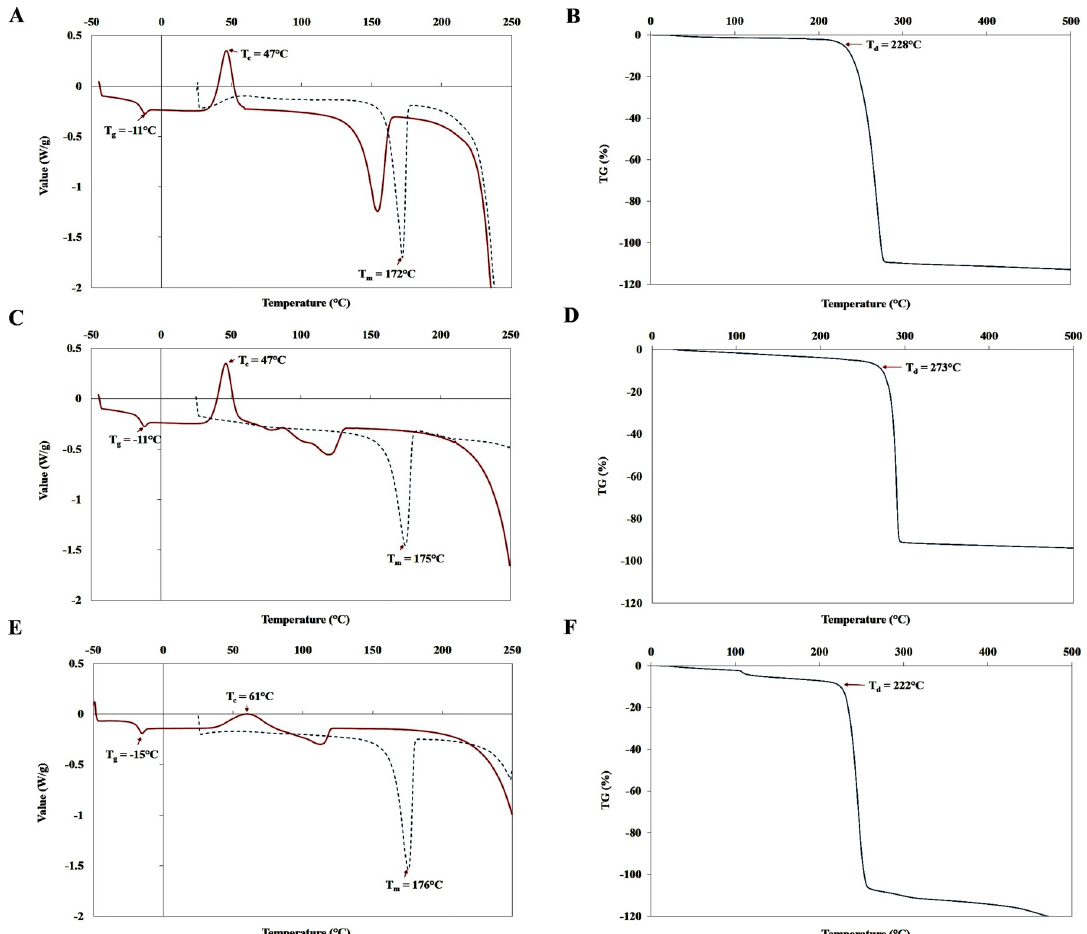
Fig 6. The melting temperature (T m ), glass transition temperature (T g ), crystallization temperature (T c ) and degradation temperature (T d ) of the PHAs obtained from EPPJ (A, B), glucose (C, D) and standard PHB (E, F) after DSC and thermal gravimetric analysis.